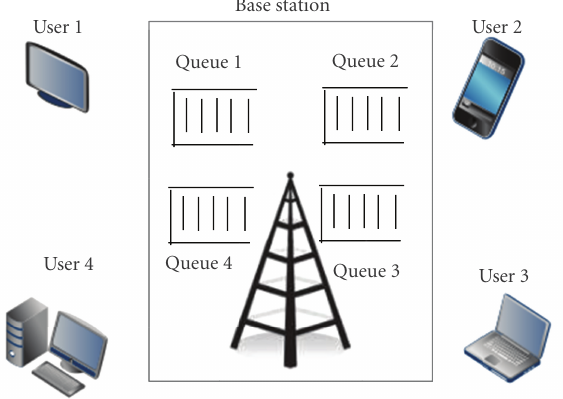
Figure 1: Typical 4G cellular network with heterogeneous